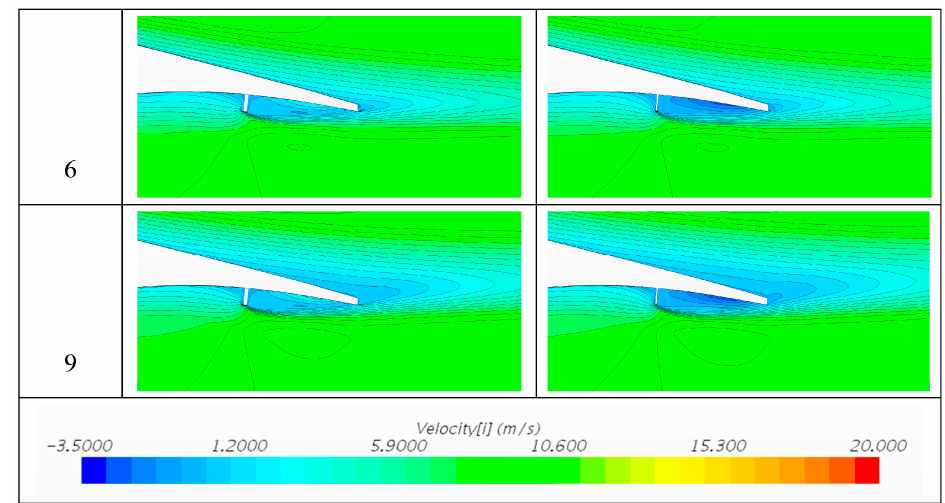
Figure 7. Qualitative comparison of velocity scalar field of the cell-set model and fully mesh model for MT implementation on a DU91W(2)250 airfoil. MT9320 configuration: x [%c] = 93%; y [%c] = 2.0%.